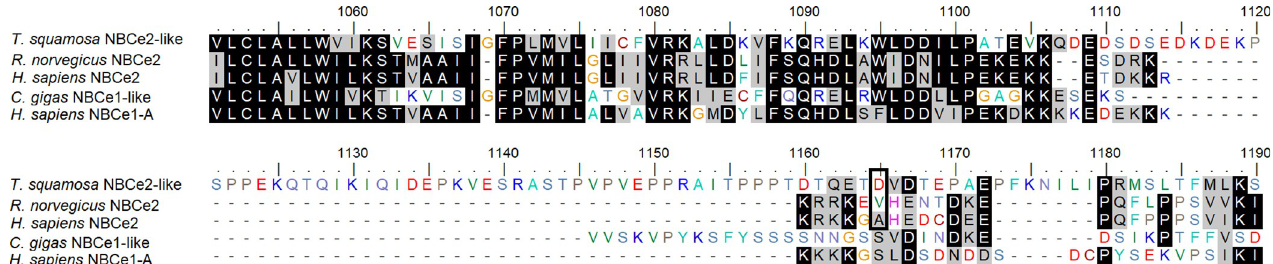
Fig 3. An aligment of the partial sequence of a homolog of electrogenic Na + -HCO 3 − cotransporter 2 (NBCe2-like protein) obtained from the outer mantle of Tridacna squamosa with the partial sequences of NBCe2 of Rattus norvegicus (NP_997677.1) as well as NBCe2 (AAK26741.1) and NBCe1-A (NP_003750.1) of Homo sapiens , in order to examine the serine residue, which can undergo phosphorylation to change the ratio of Na + : HCO 3 − transport. Similar/identical amino acid residues are shaded. The asterisk denotes the serine residue (position 1165 based on the multiple amino acid alignment) that can be phosphorylated to induce a shift in the Na + : HCO 3 − stoichiometry from 1: 3 (efflux of HCO 3 − ) to 1: 2 (influx of HCO 3 − ). This serine residue (highlighted by a box) is present only in NBCe1-A of human (Ser 982 based on the human sequence), but is lacking in NBCe2-like protein of T . squamosa , as well as NBCe2 of R . norvegicus and H . sapiens .